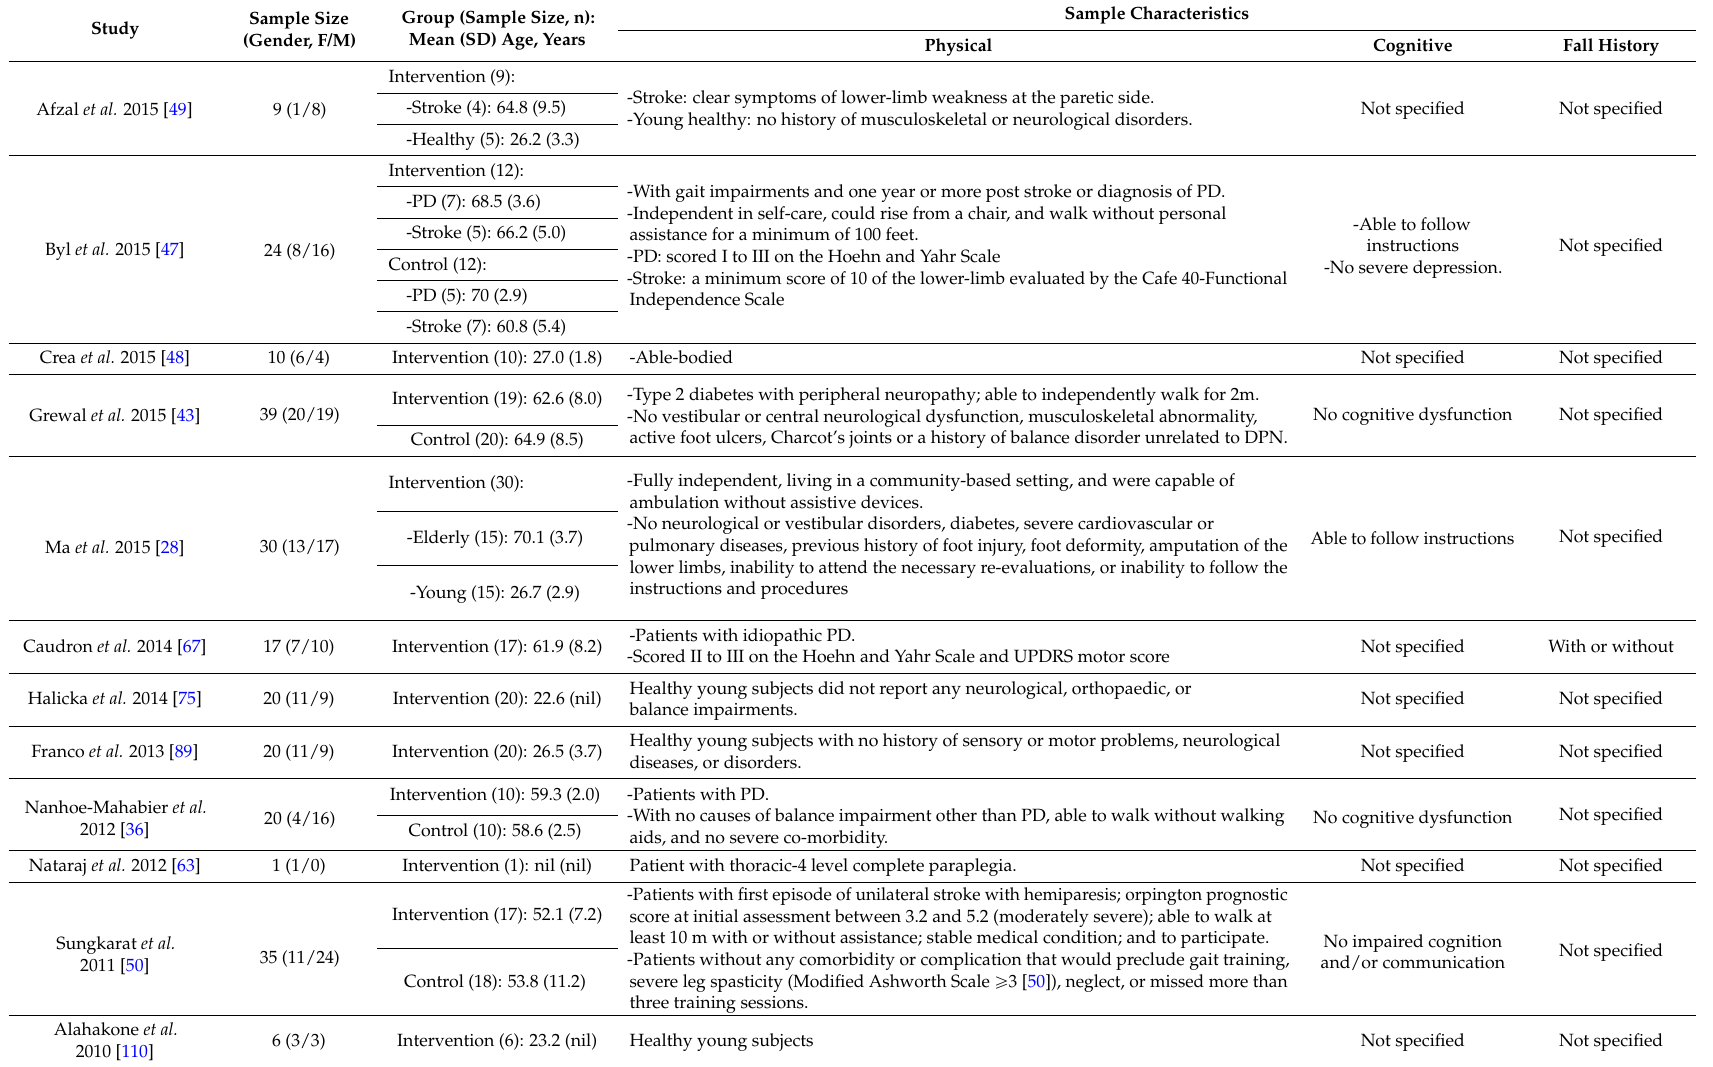
Table 7. Subject characteristics ( n =